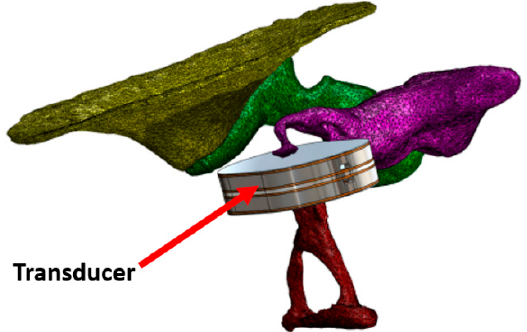
Figure 6. Transducer to estimate the force passing through the incudostapedial joint. Open Access © 2014 [59] © 2022 MDPI.